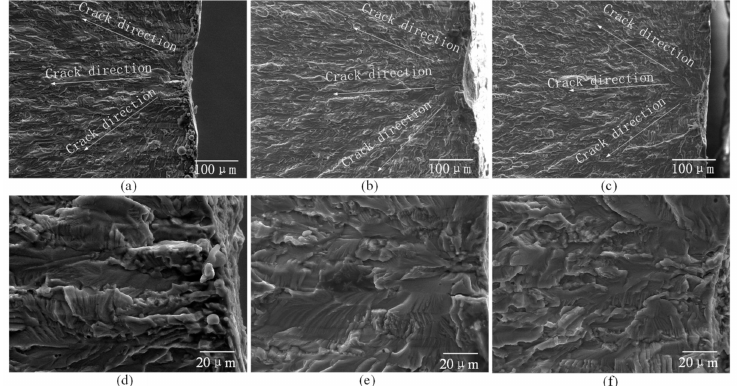
Figure 6. SEM morphologies of fatigue crack initiation regions of the 7075 aluminum alloy at di ff erent prebending radii ( S max = 260 MPa). ( a,d ) 1500 mm; ( b,e ) 1000 mm; ( c,f ) 500